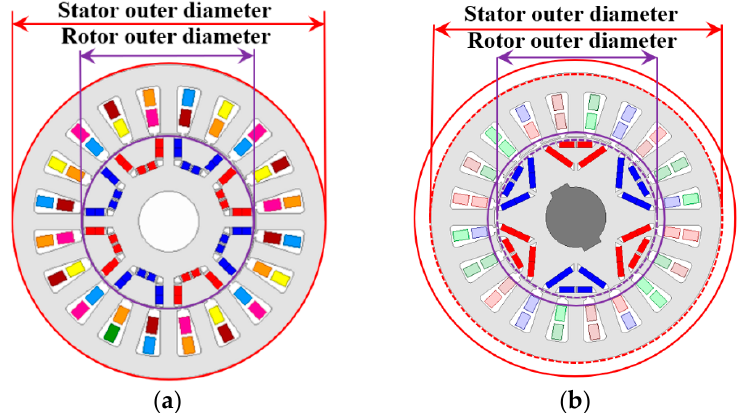
Figure 22. Motor in IMDS topology: ( a ) Ver1.0 motor topology, ( b ) Ver2.0 motor topology. The Red and purple lines in Figure 22a,b represent the stator outer diameter and the rotor outer diameter, respectively, and the solid-line curve and dash-line curve represent Ver1.0 motor size and Ver2.0 motor size, respectively. It can be concluded that, through